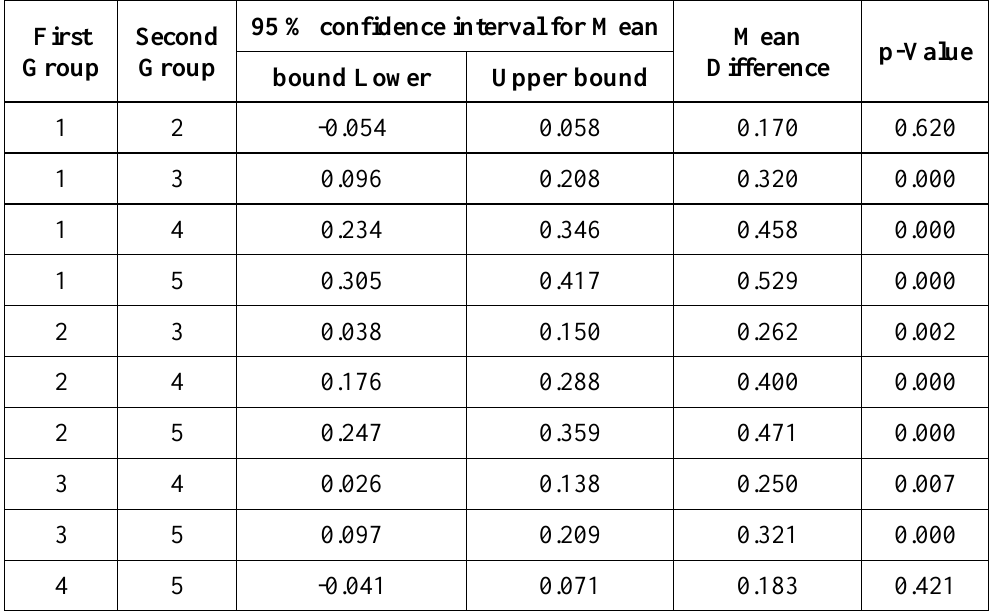
Table 9. One-Way ANOVA of Beta Coefficient Mean in Pairwise